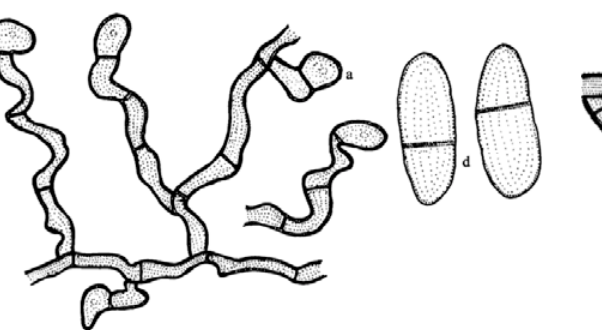
Figure 10. Armatella cinnamomicola a - Appressoria,;d -